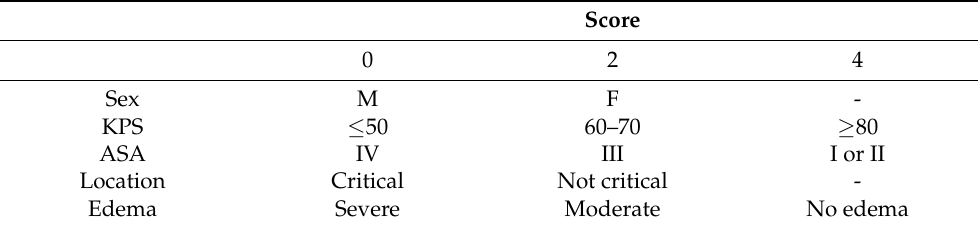
Table 1. Summary of the SKALE single parameters and corresponding score value